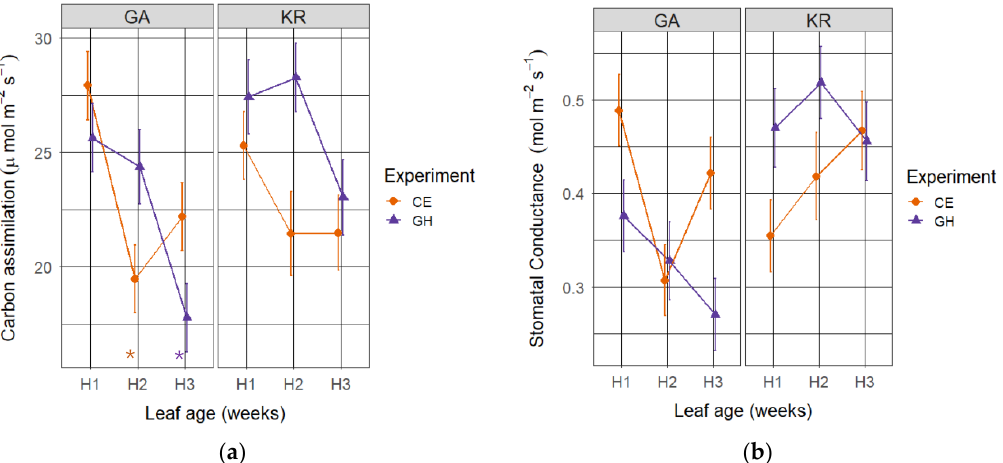
Figure 3. The impact of leaf age on ( a ) CO 2 assimilation ( A ) and ( b ) stomatal conductance ( g s ) in two wheat cultivars (KR, Krichauff; GA, Gatsby) grown in the glasshouse (GH) or controlled environment (CE) chamber. Orange and purple asterisks indicate significant difference from harvest 1 (H1) in the CE and GH experiments, respectively. Gas exchange was measured at 400 µ mol mol − 1 CO 2 , PPFD = 1800 µ mol m − 2 s − 1 , and 26 ◦ C (block temp), in young expanding (H1-21 DAS), fully expanded (H2-28 DAS) and mature (H3-35 DAS) leaves. Data points represent the means ± standard errors of 6 biological replicates.